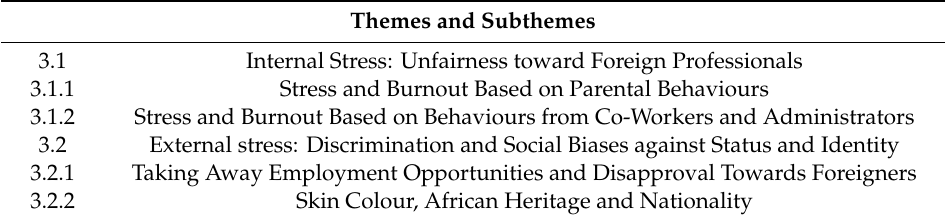
Table 2. Themes and